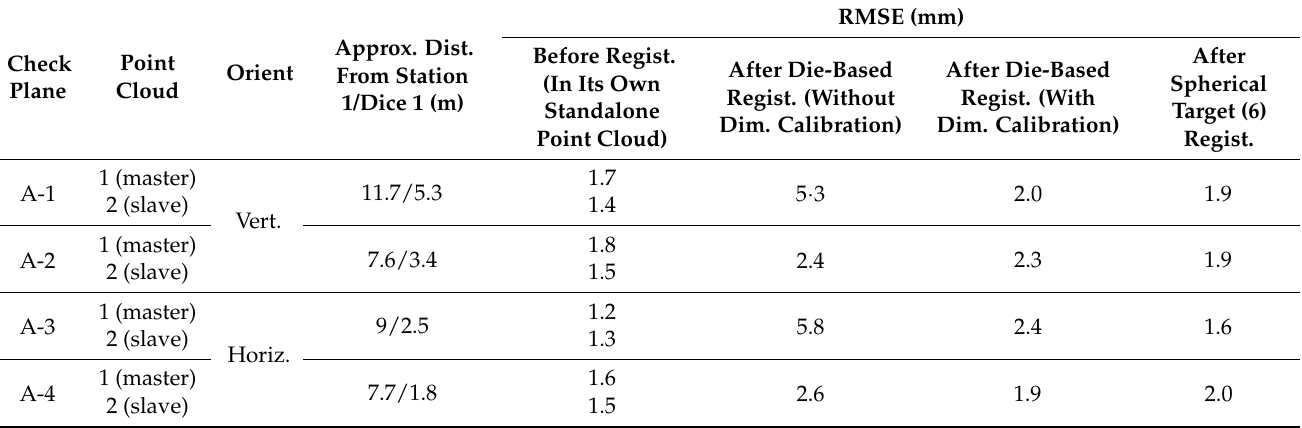
Table 2. RMSEs of check plane residuals before and after the registration. (Dataset A, die dimension = 50 cm × 50 cm × 50